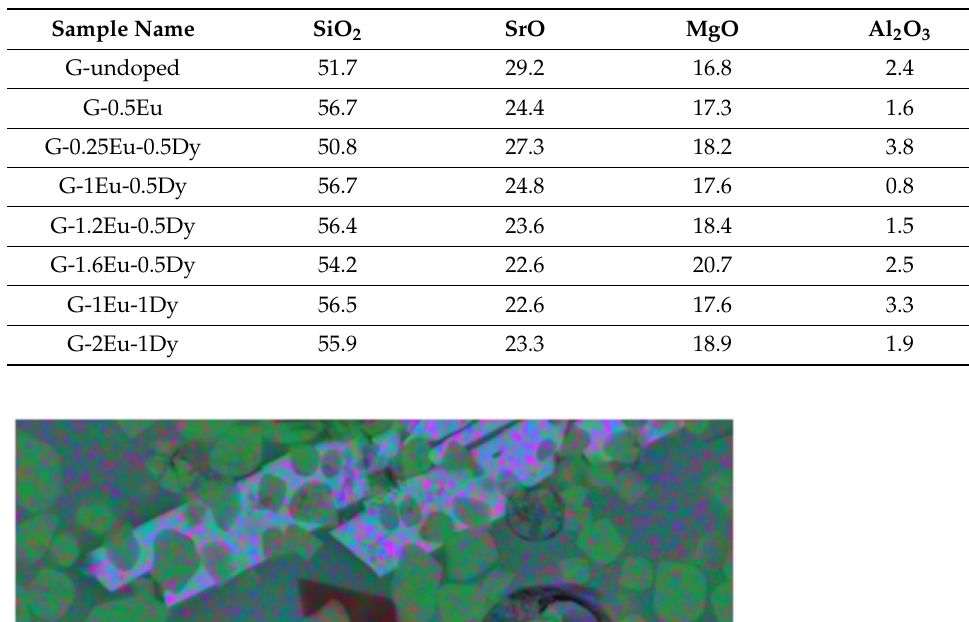
Table 7. EDX analysis of glass frits (mol%.). Samples were compositionally accurate within the uncertainty in the EDX (~1%).